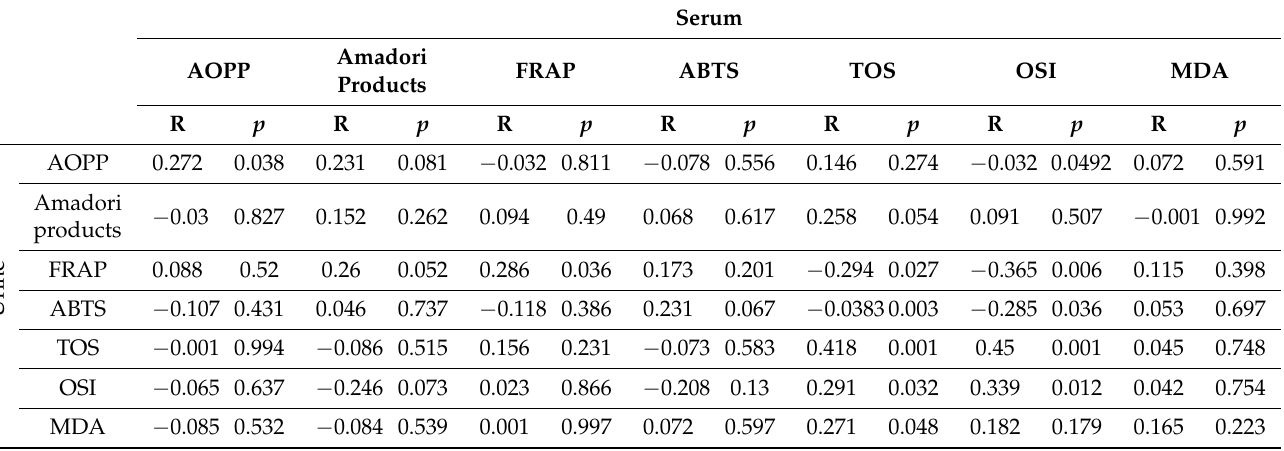
Table 5. Spearman’s rank correlation coefficients and p values between oxidative stress parameters in serum and urine